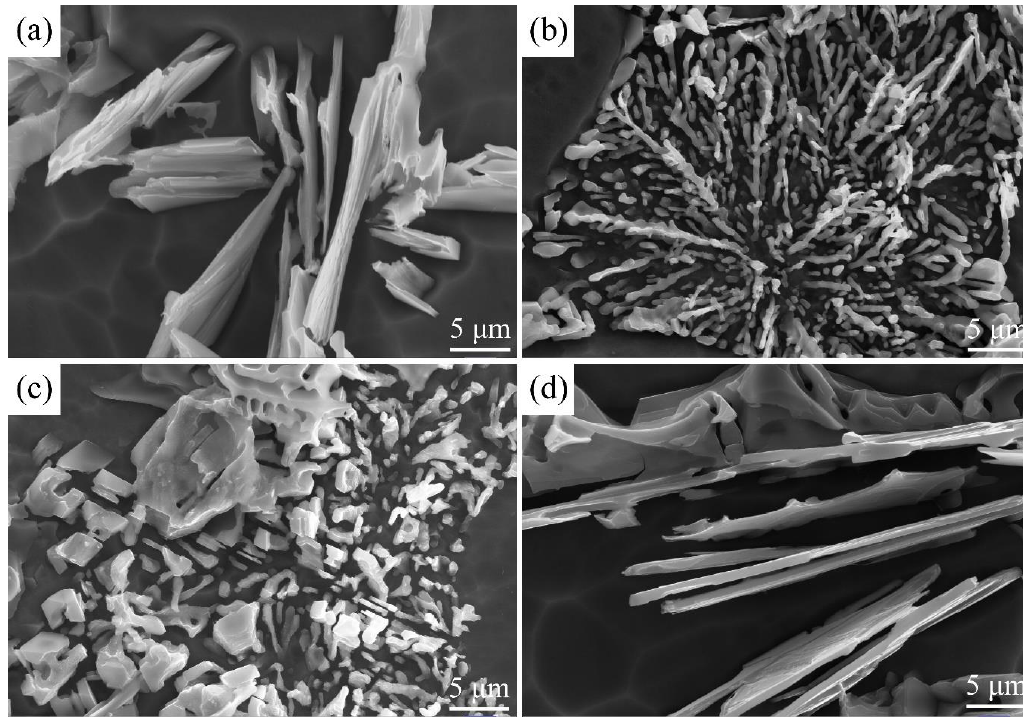
Figure 6. Stereoscopic morphology under SEM (( a ) unmodified; ( b ) residual amount of Sr = 0.0384%; ( c ) residual amount of Sr = 0.0083%; ( d ) residual amount of Sr = 0.0011%).